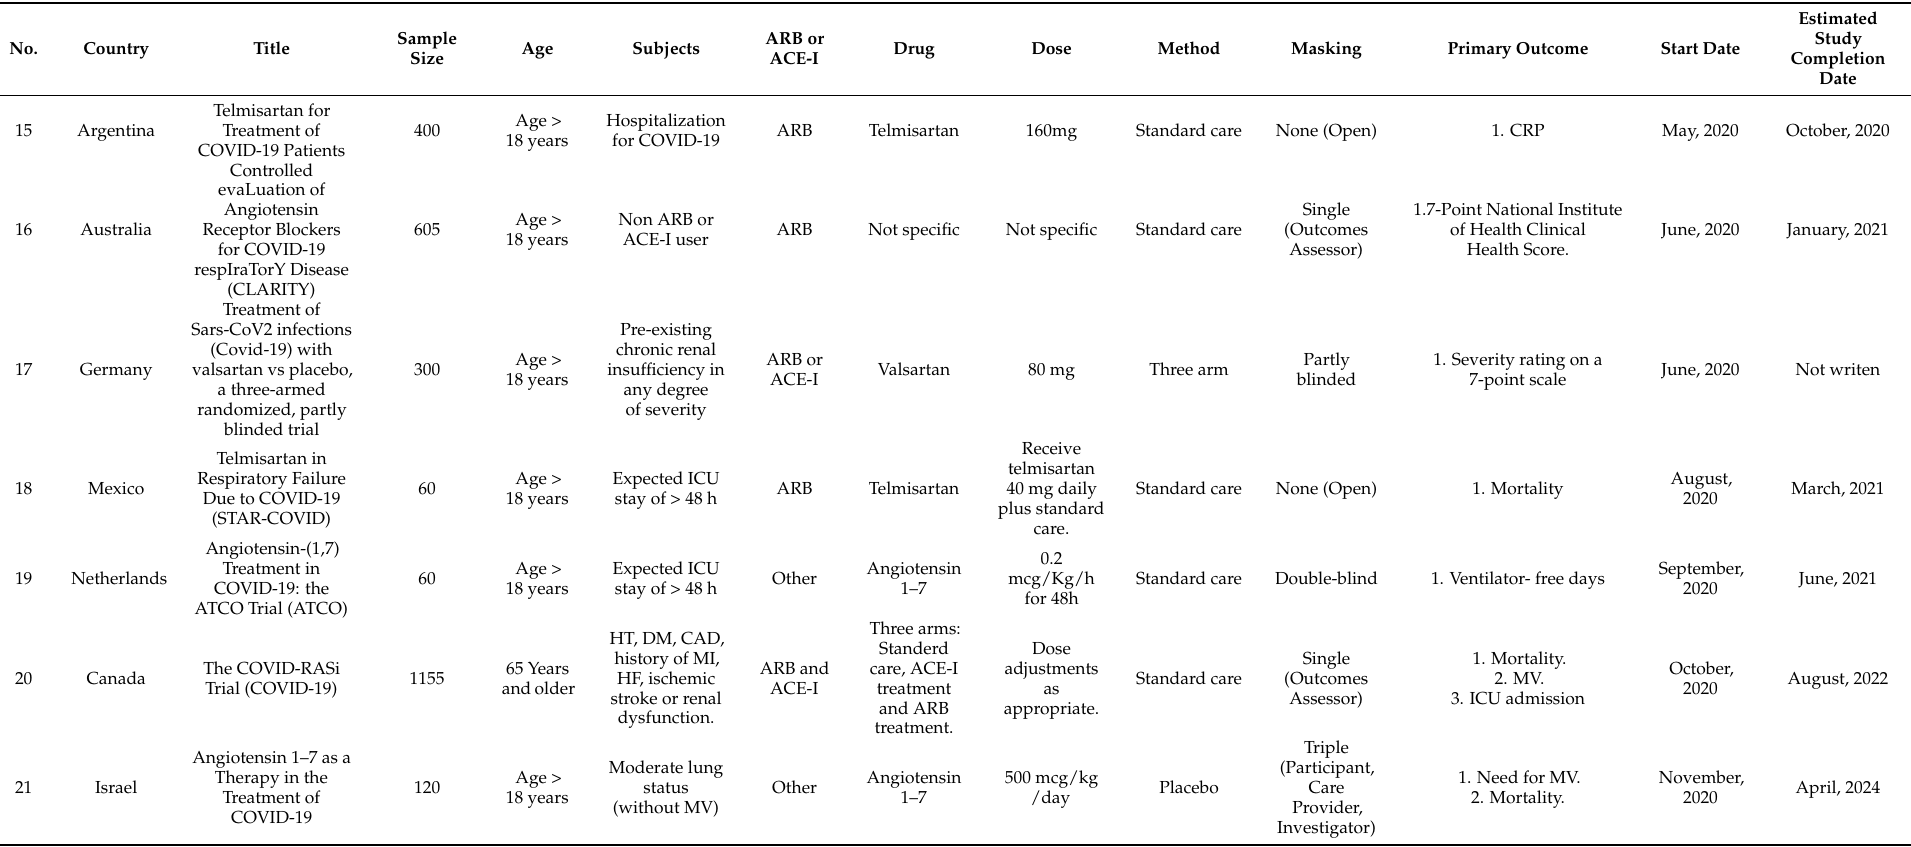
ACE-I: Angiotensin-converting-enzyme inhibitor, ARB: Angiotensin II Receptor Blocker, CAD: Coronary artery disease, CRP: C-reactive protein, DM: Diabetes mellitus, ECMO: Extracorporeal membrane oxygenation, HF: Heart failure, HT: Hyper tension, ICU: Intensive care unit, MI: Myocardial infarction, MV: Mechanical Ventilation, RRT: Renal replacement therapy, SBP: Systolic blood pressure, SOFA: Sequential organ failure assessment